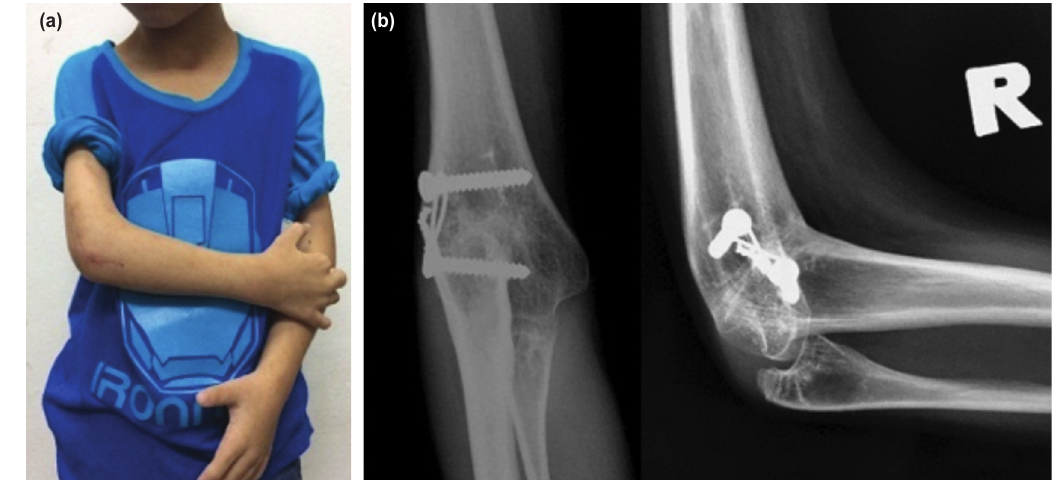
(a) Post-operative photograph and (b) plain radiographs taken one year after surgery showing right elbow position of 90 Fig. 3: degrees and union of osteotomy site.